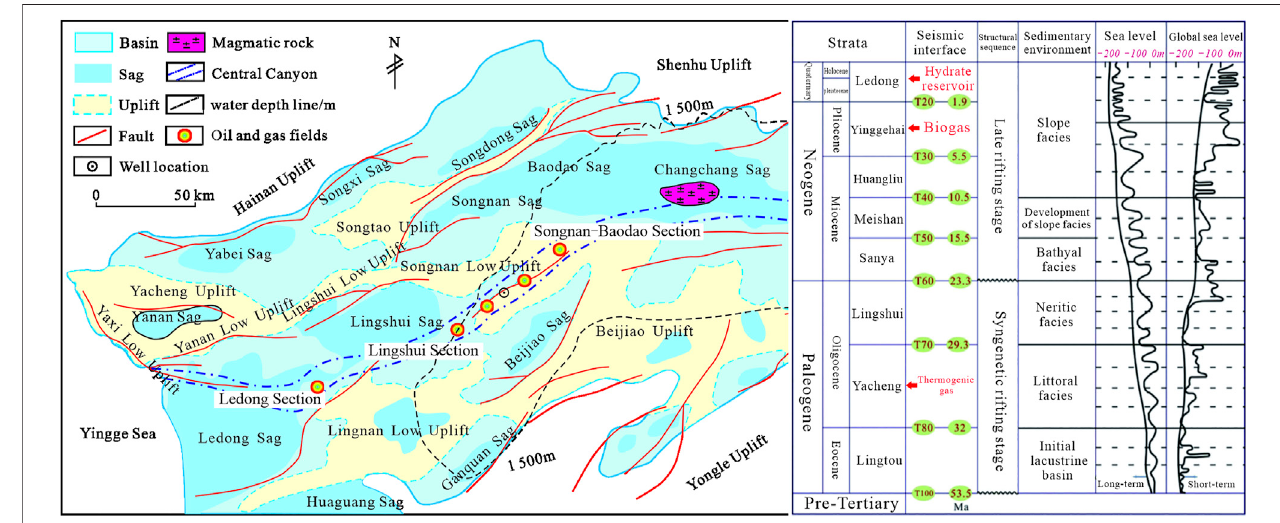
FIGURE 1 | Regional tectonic position and stratigraphic histogram of Qiongdongnan Basin.